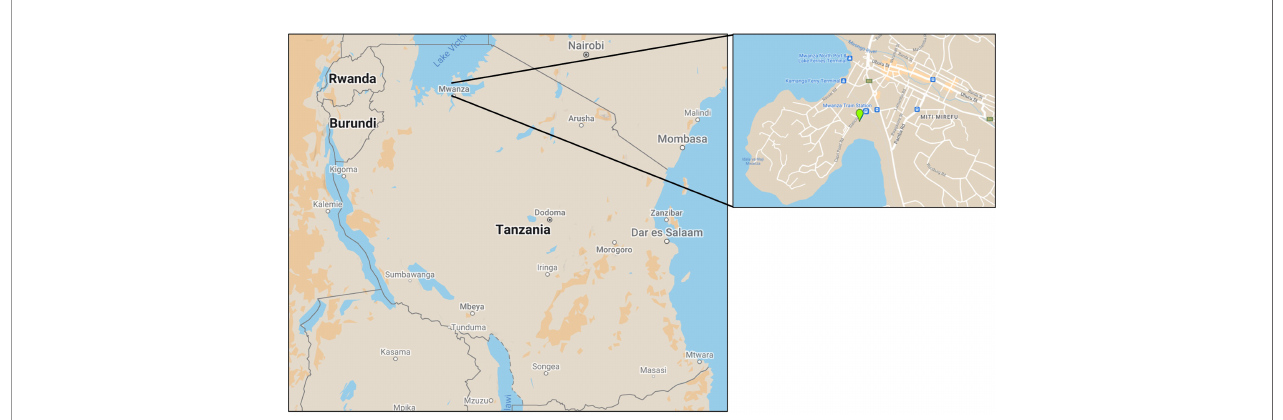
FIGURE 1 | Map depicting the country of Tanzania where Mwanza is located at the shores of Lake Victoria. The enlarged section to the right shows Mwanza, which was the focus of this study, including the location of the fi eld site [2°31 ’ 24.71 ” S, 32°53 ’ 51.46 ” E] (Map data ©2022 Google).